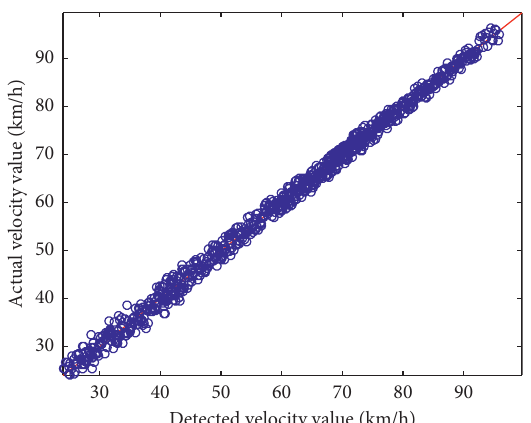
Figure 7: Actual velocity value and the detected velocity value calibrating based on the RBF neural